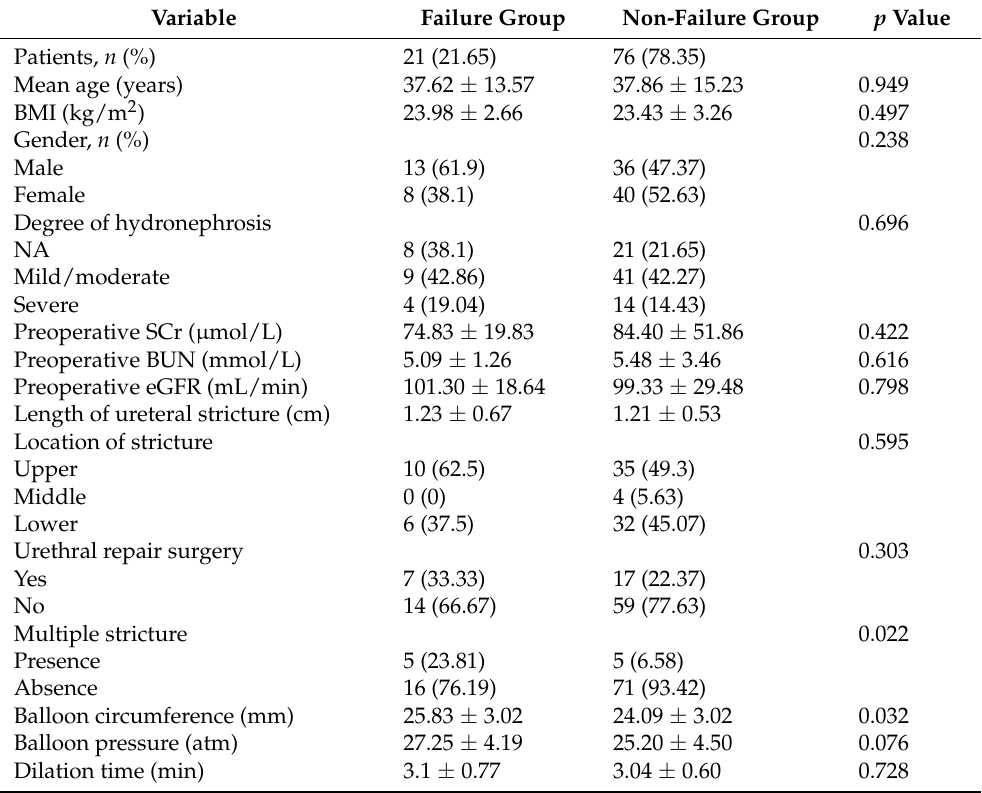
Table 3. Demographic and clinical characteristics of 97 patients.